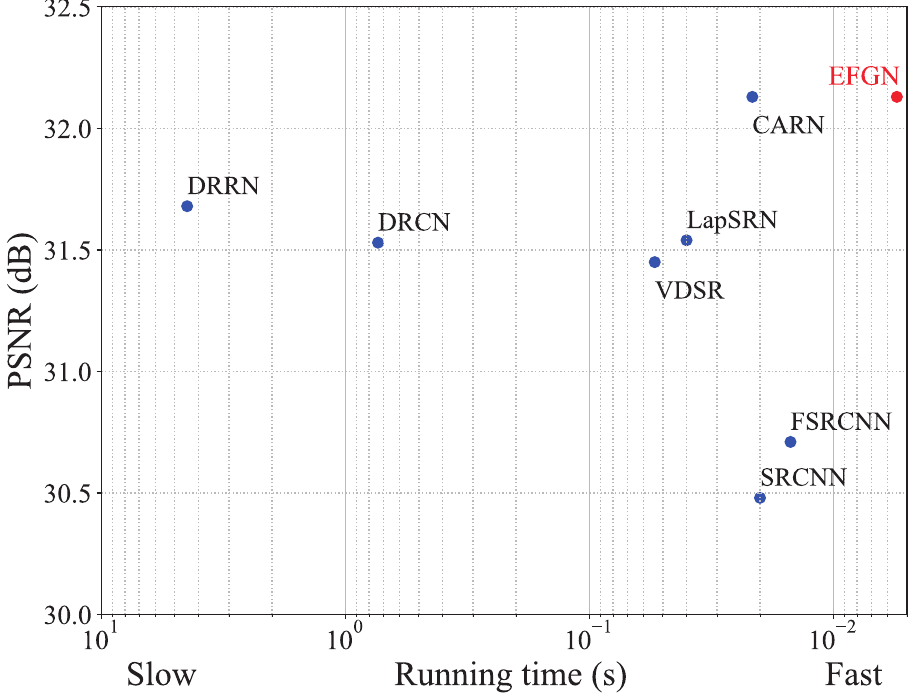
Figure 5. The trade-off between the running time and PSNR with scale factor × 4 on